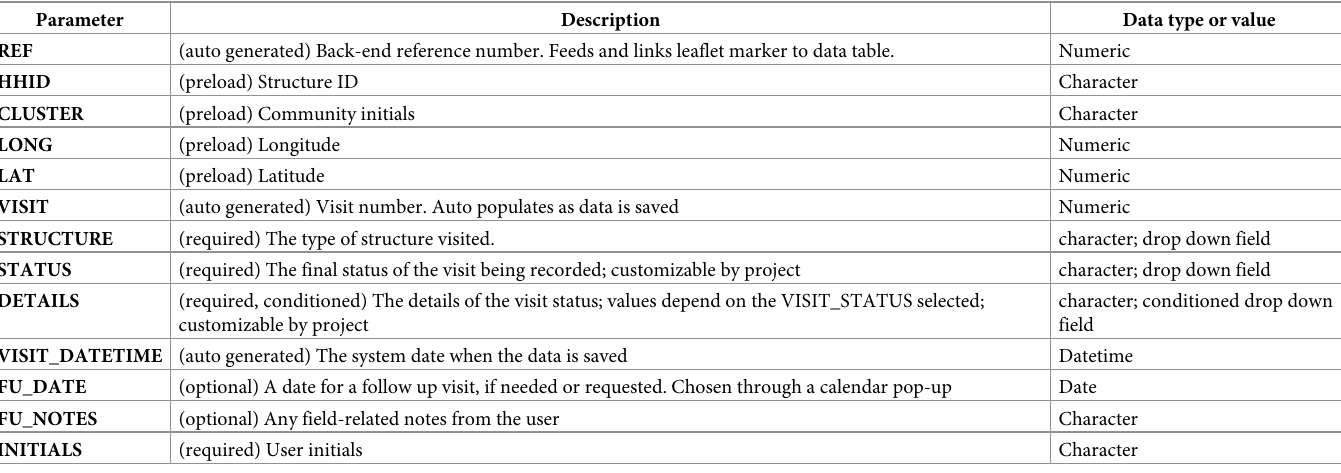
Table 1. Data table fields used for the COPA